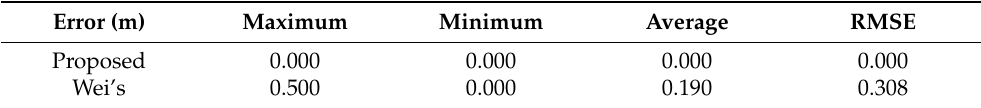
Table 1. The error on the XOY plane.